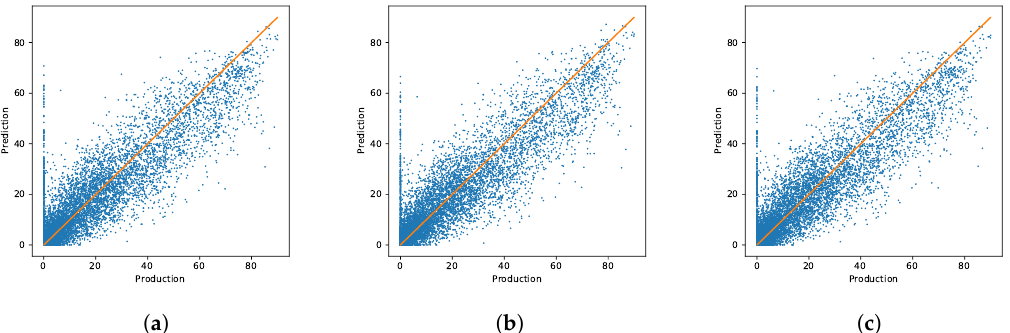
Figure 7. Real energy production against prediction made by the best CTL ( a ), ITL ( b ), and MTL ( c ) models for Sotavento; the perfect prediction line is shown in orange. The units of the axis are percentages points of the total PV energy installed.